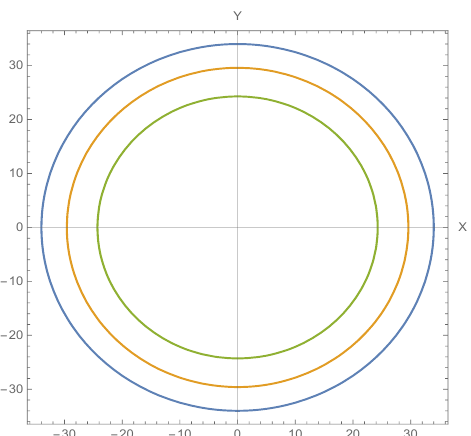
Figure 4. Plot of the shadow contour with varying ξ , with β = 12 and M = 1. The blue curve has ξ = 7.1, the yellow ξ = 6.1 and the green has ξ =